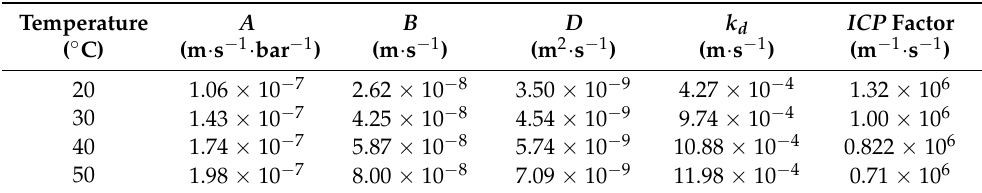
Table 3. Parameters of solution properties, fluid mechanics and membrane properties. The studied draw solution is 35 g/kg (about 0.6 M) NaCl solution [16,19].